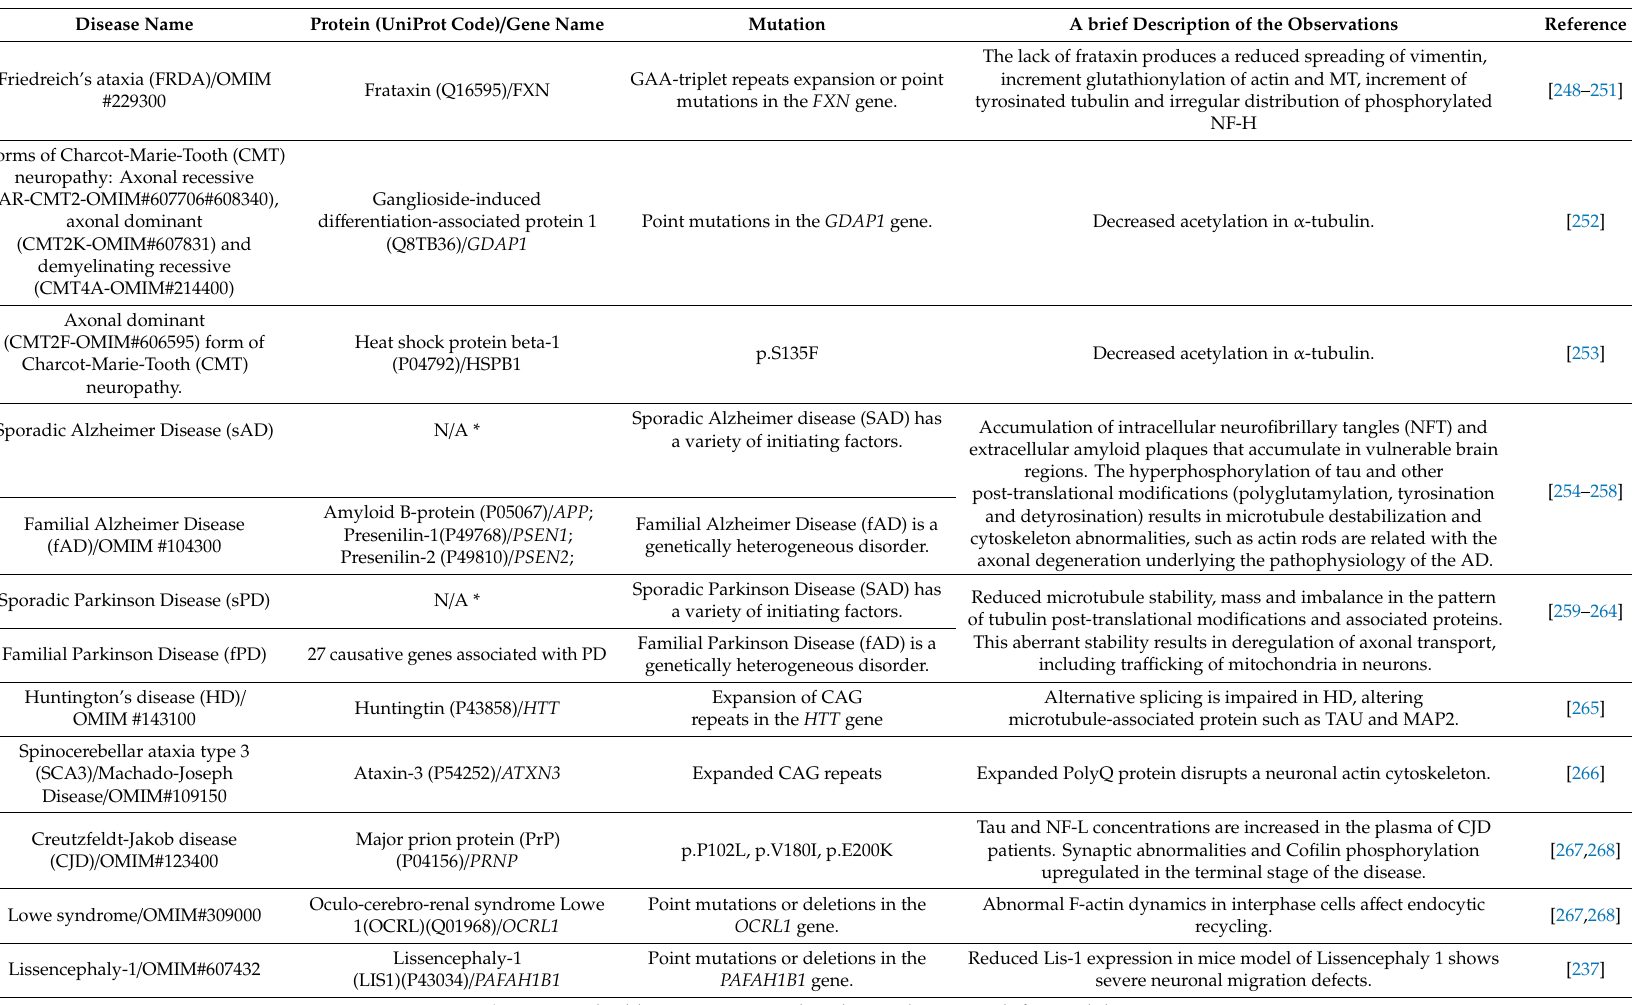
Table 3. Neurological disorders in which abnormalities of the cytoskeleton appear as a secondary pathophysiological